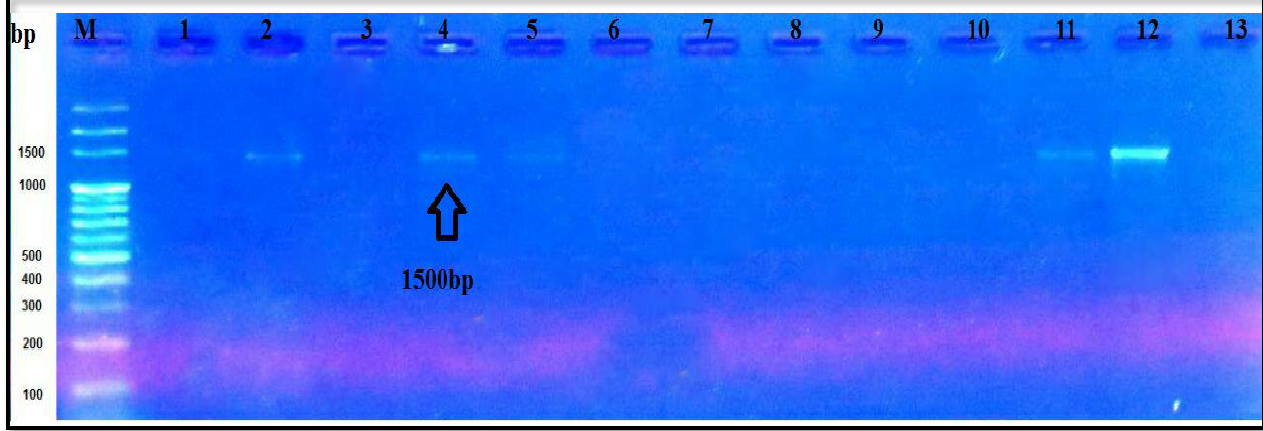
Figure 2. Agarose gel electrophoresis of PCR products for 16S rRNA gene. The amplified fragment is expected to have a molecular size of 1500 bp. The product was electrophoresed on 1.5% agarose for 1hr. M=DNA ladder (100